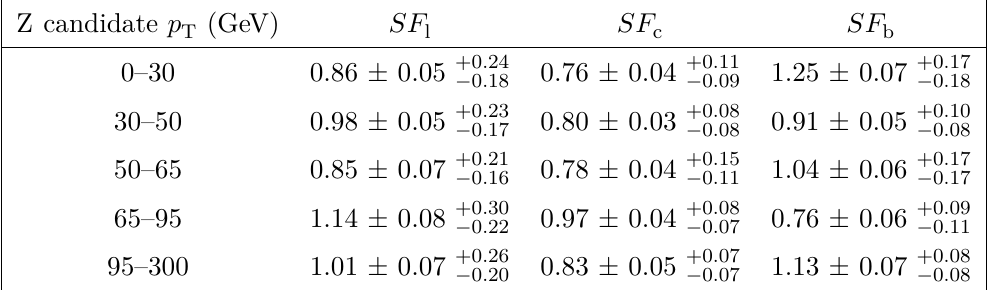
, Z + c jet SF , and Z + b jet SF scale factors measured in the l c b . The first uncertainty is the statistical uncertainty T